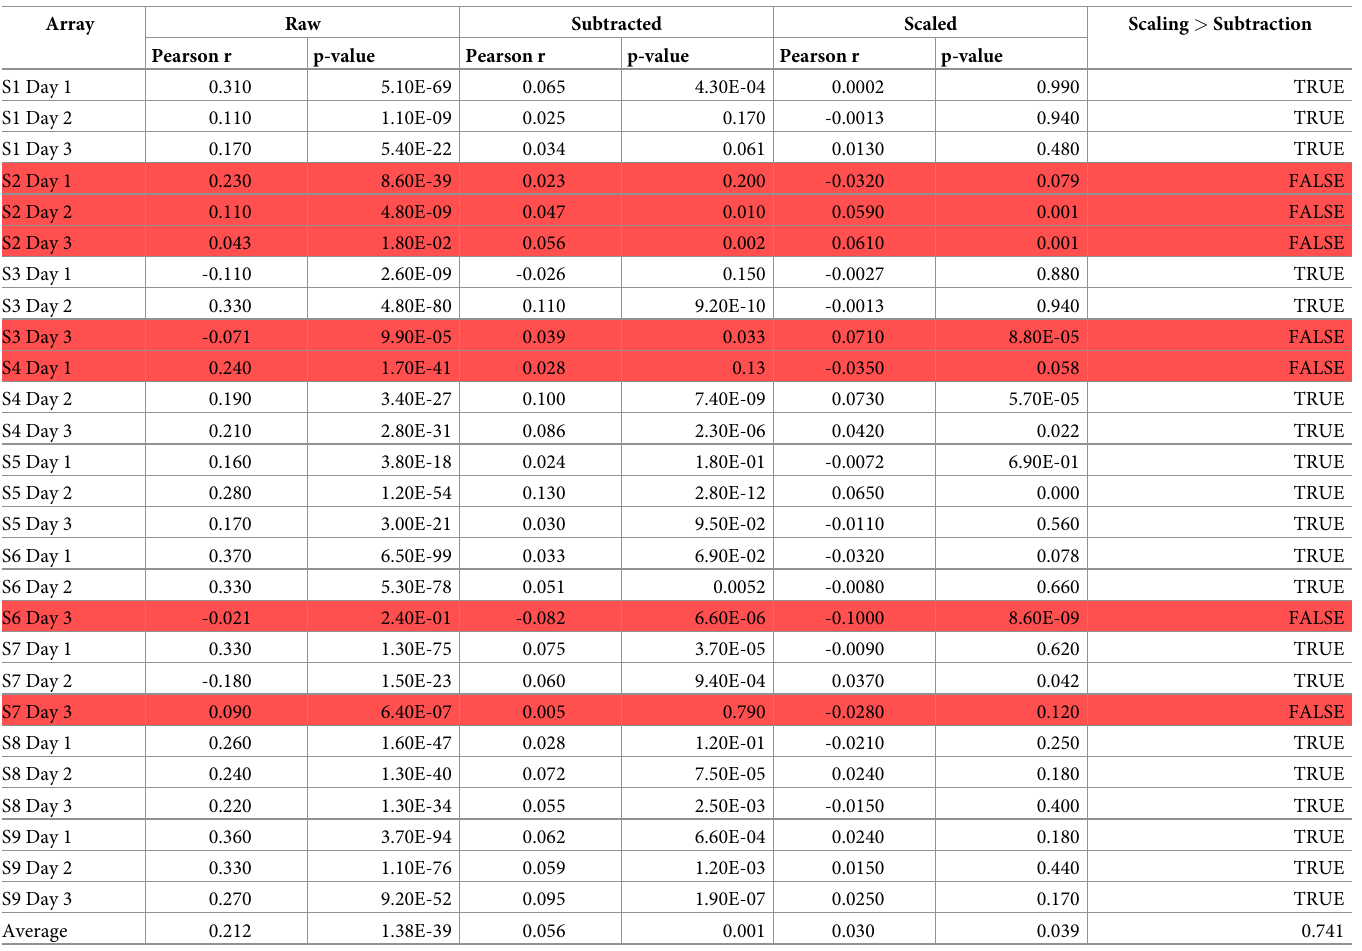
Table 1. Comparison of different background correction methods on correlation between y-axis location and probe intensity.